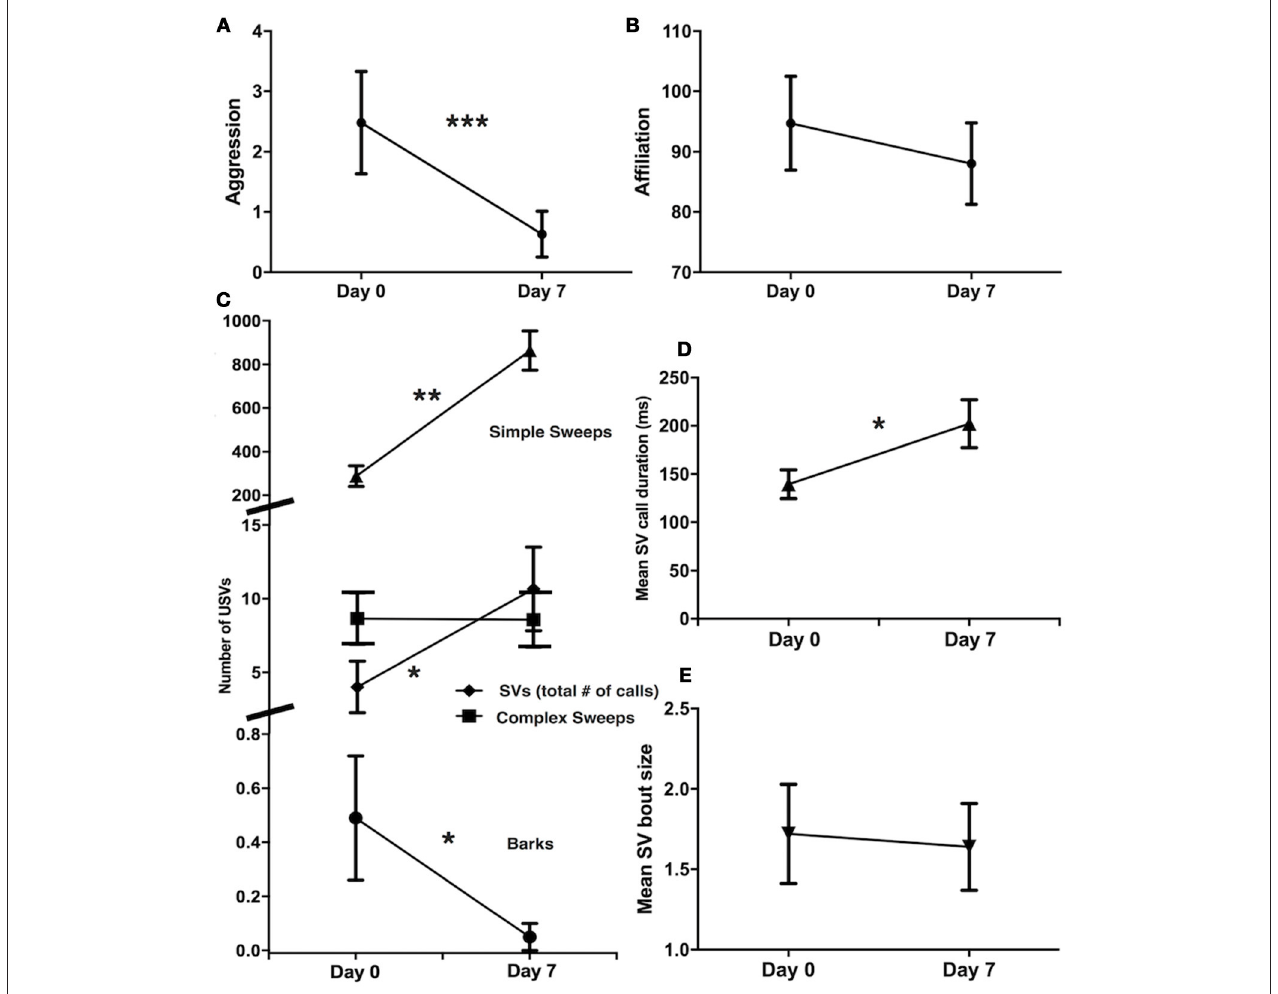
FIGURE 2 | Changes in aggression and USVs from pair introduction (day 0) to pair development (day 7). (A) Decrease in aggression ( N = 43). (B) No change in affiliation ( N = 43). (C) Decrease in barks, increase in simple sweeps and SVs, no change in complex sweeps ( N = 43). (D) Increase in mean SV call duration ( N =